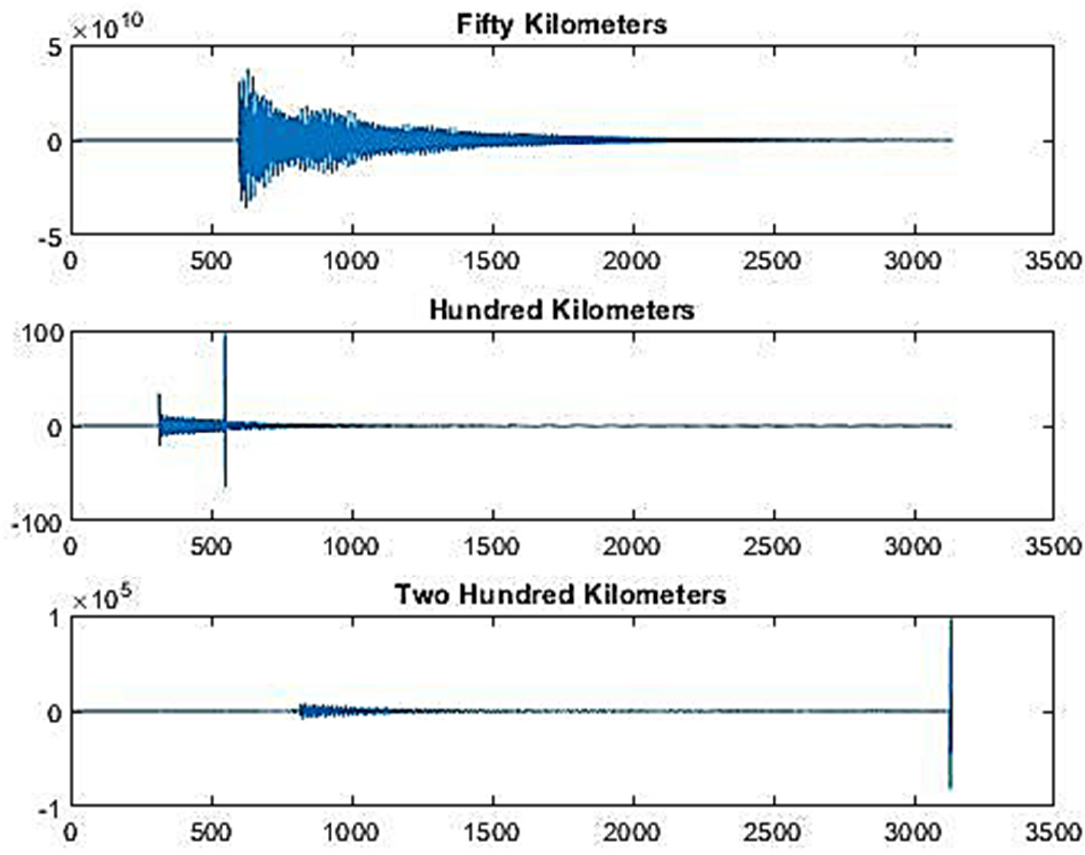
Figure 13. Comparison of different line lengths.